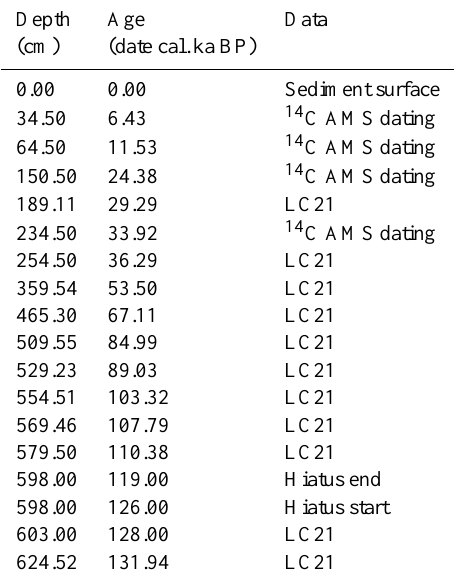
Table 2. Data used for constructing the age model for the investi- gated sediment core GeoTü SL110. Oxygen isotope ages are based on a graphical correlation with the LC21 record (Grant et al., 2012) from the southern Aegean Sea.